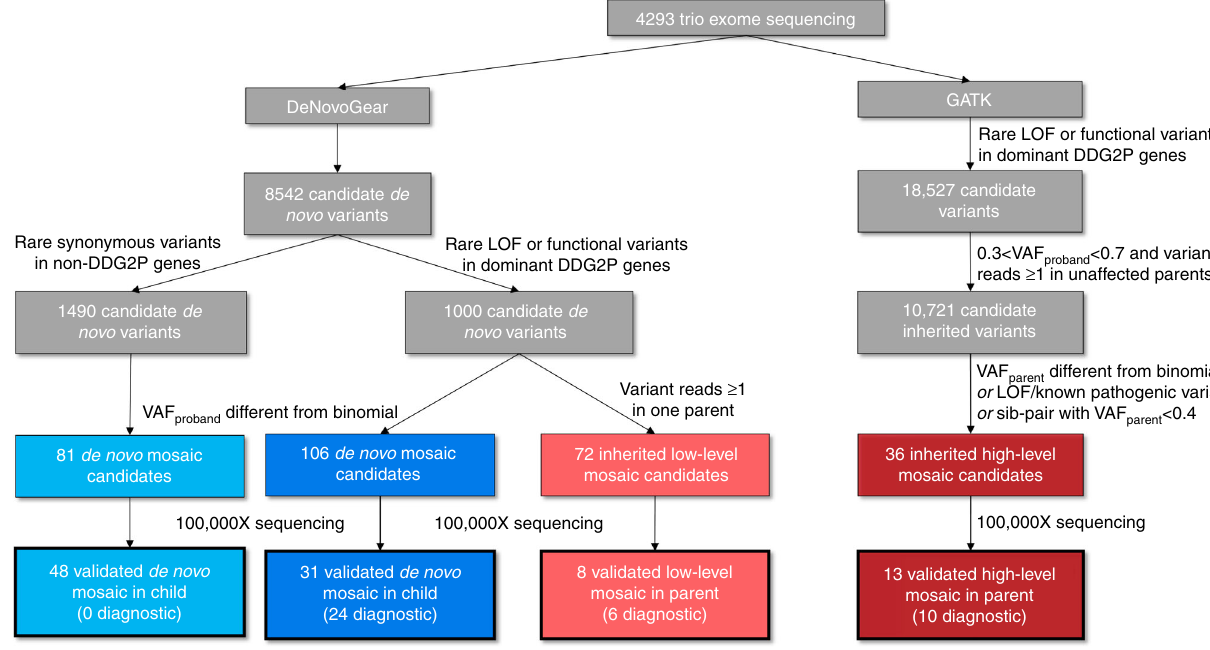
Fig. 2 Variant selection fl owchart. Flowchart outlining variant selection for high-depth sequencing validation experiments. Candidate DNMs from trio exome sequencing were used to select candidate mosaic DNMs in the proband (blue) as well as ‘ low level ’ mosaic variants in a parent (light red) for validation; candidate inherited variants were used to select ‘ high level ’ mosaic variants in a parent (dark red) for ultrahigh-depth